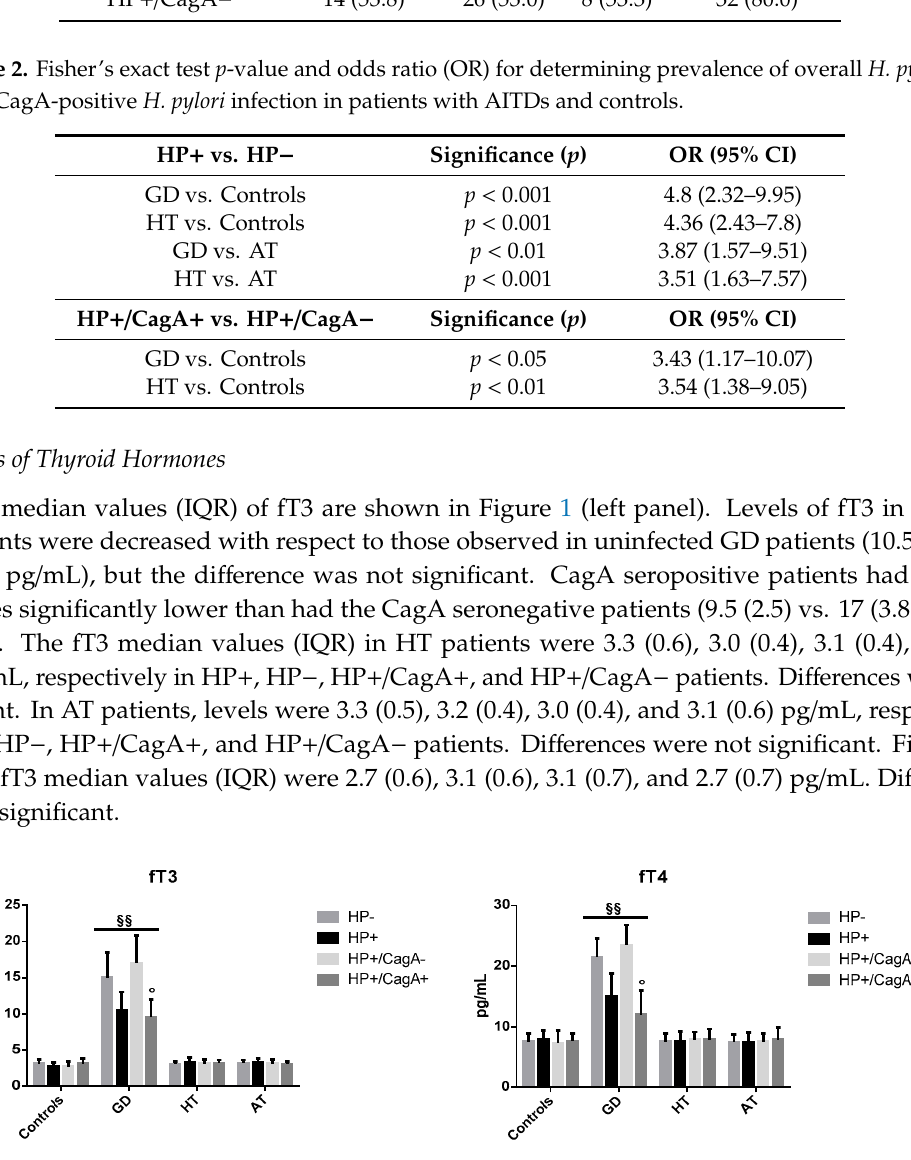
Figure 1. Median (IQR) values of fT3 ( left and fT4 ( right ) in patients with di ff erent clinical forms of AITD and controls according to the overall H. pylori and CagA infectious status. ◦ p < 0.05: HP +/ CagA + vs. HP +/ CagA − , §§ p < 0.01 AITDs vs.